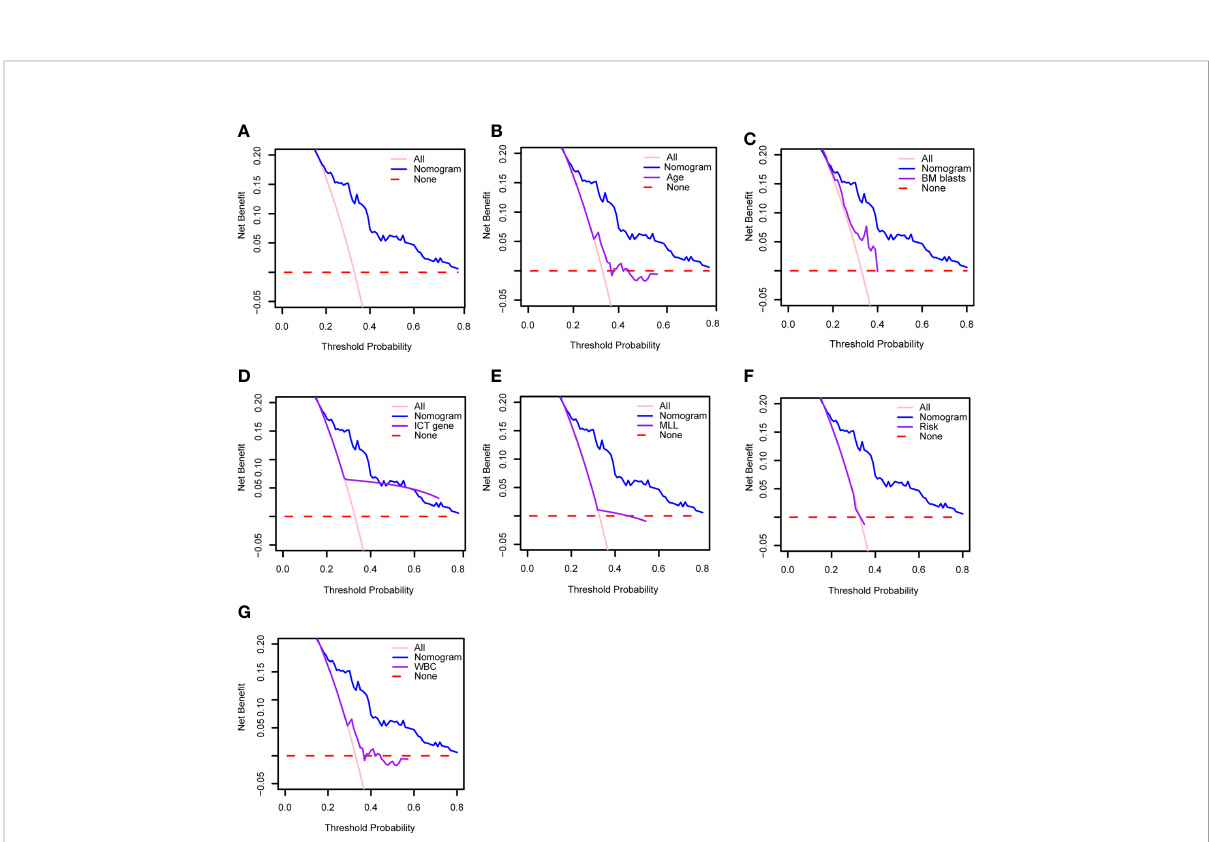
FIGURE 7 (A) Decision curve analysis of the clinical use of our model based on the nomogram. Decision curve analysis of the prediction value comparison between our model and these single indicators: (B) age, (C) BM blasts, (D) ICT gene, (E) MLL, (F) risk and (G) WBC. WBC, white blood cell counts; BM, bone marrow; ICT gene, if carried one or more of IKZF1, CREBBP and